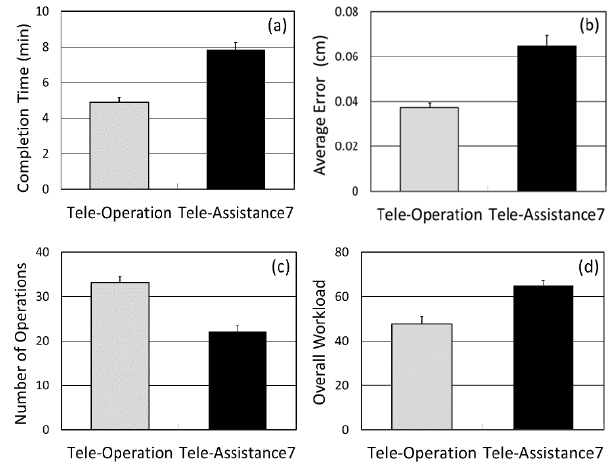
Figure 5. Results of Experiment I: ( a ) Average completion time of the task; ( b ) Average error of performing the task; ( c ) Average number of operations executed by the participants; ( d ) Average workload perceived by the participants. (Error bars represent standard error.)